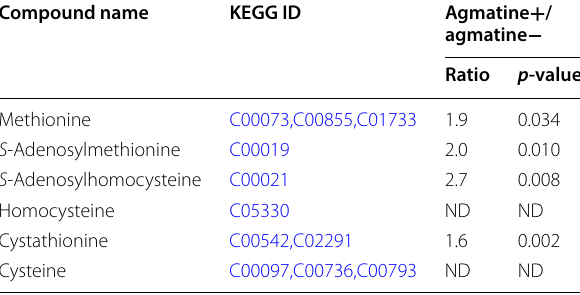
Table 2 Changes in metabolites of the methionine cycle after addition of agmatine